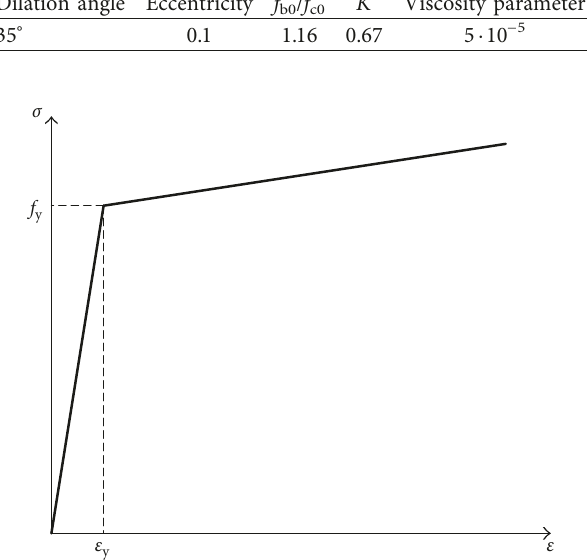
Figure 10: Stress-strain curve for the